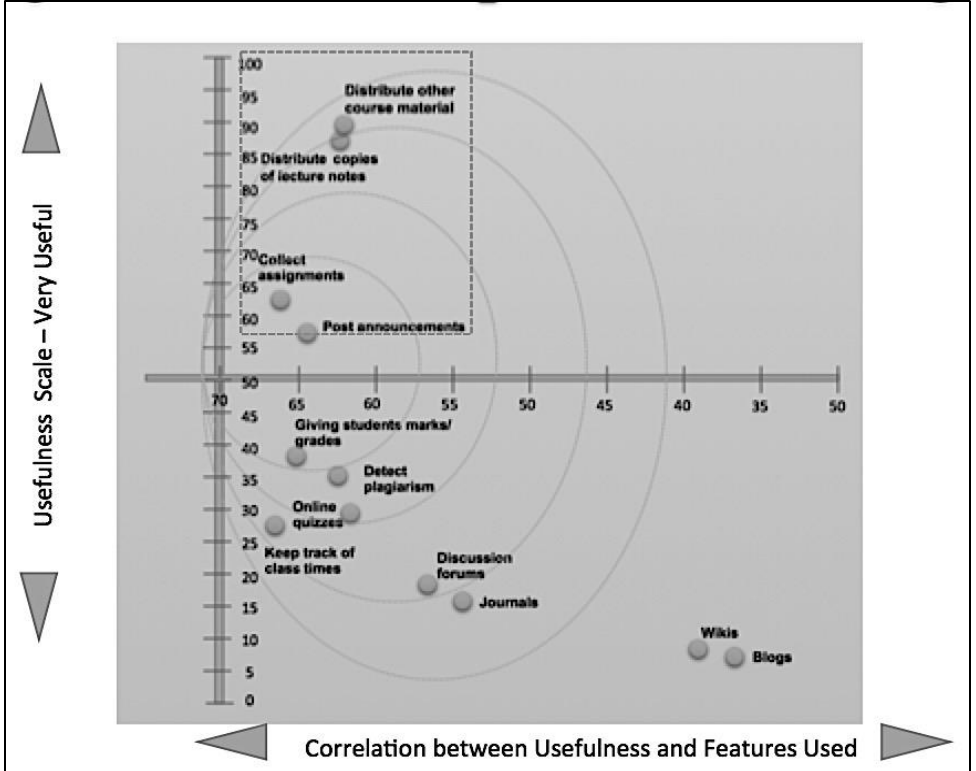
Figure 7: Relationship between perceived usefulness and VLE features used The left axis shows the scale for perceived usefulness with anything above the intersecting line being very useful. The features are then plotted according to how they correlate with perceived usefulness. This replicates and confirms the findings outlined in Figure